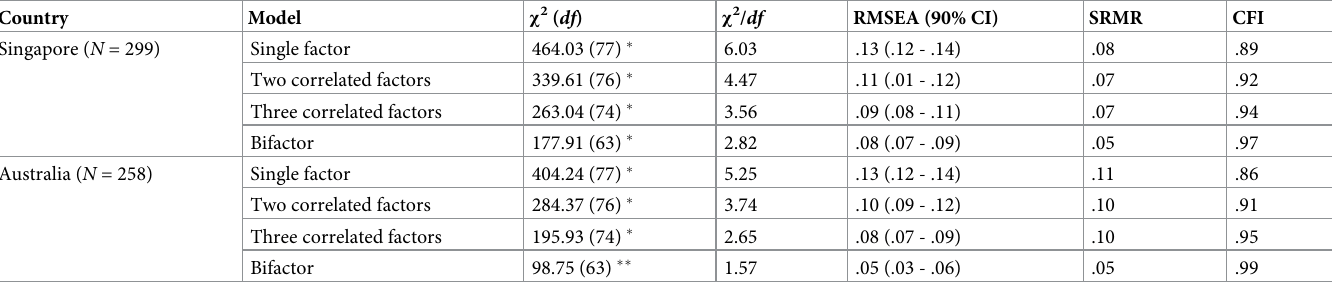
Table 4. Confirmatory factor analysis fit statistics for the MHC-SF.